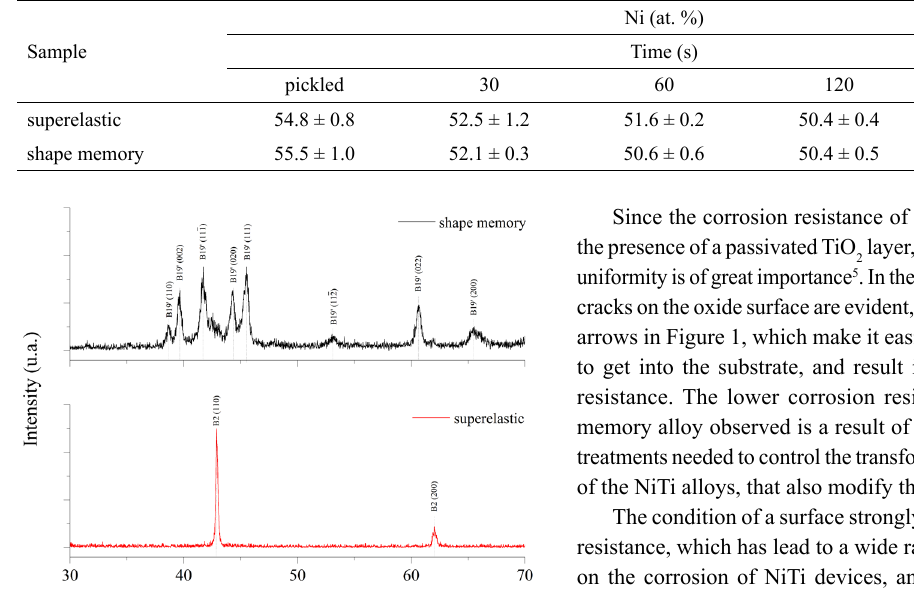
Table 2. Superficial nickel content after electrolytic polishing at different times determined by EDX.